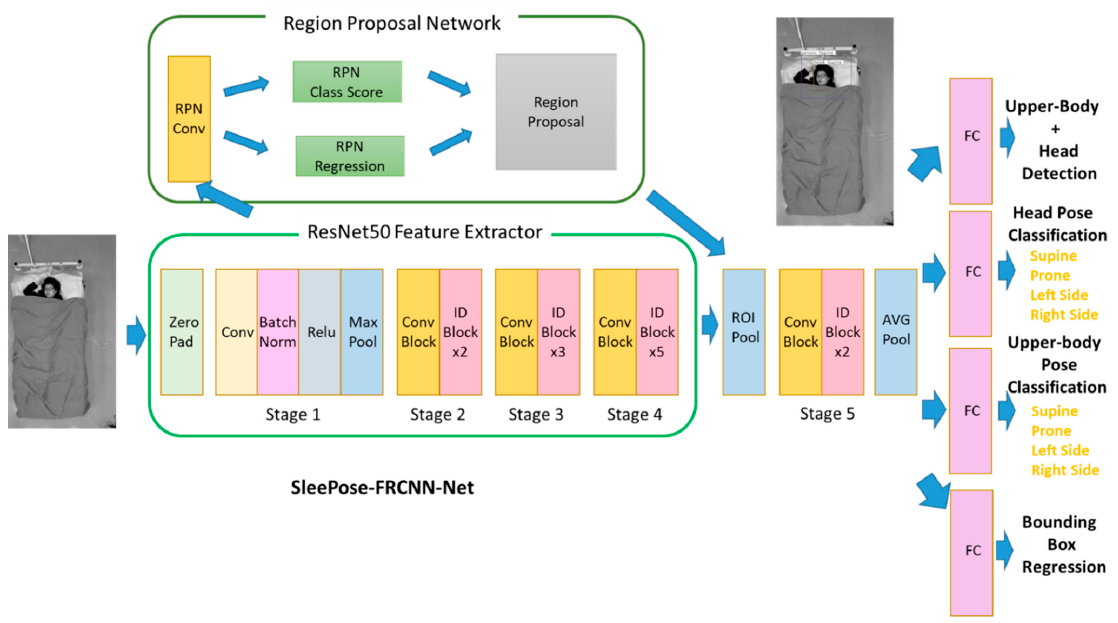
Figure 2. SleePose-FRCNN-Net architecture.